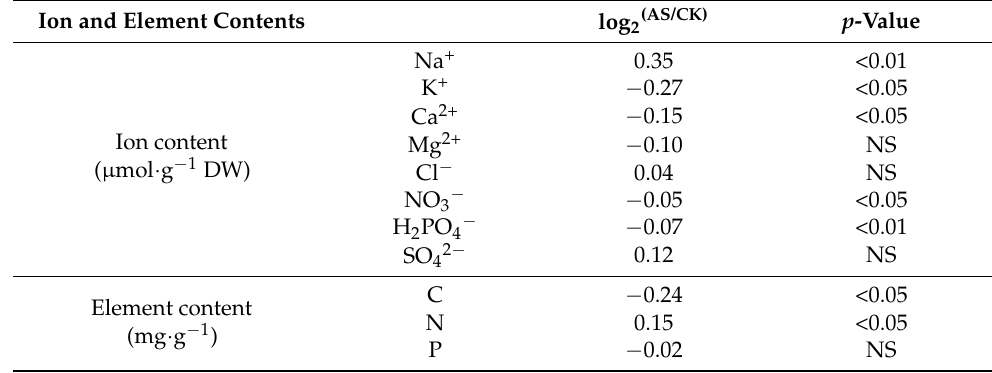
Table 3. The contents of ions and elements of L. chinensis under normal and alkali conditions. The fold changes were calculated using the formula log 2(alkali/control) . Significant differences between control and alkali stress were defined with the t-test and labeled as p < 0.05 and p <